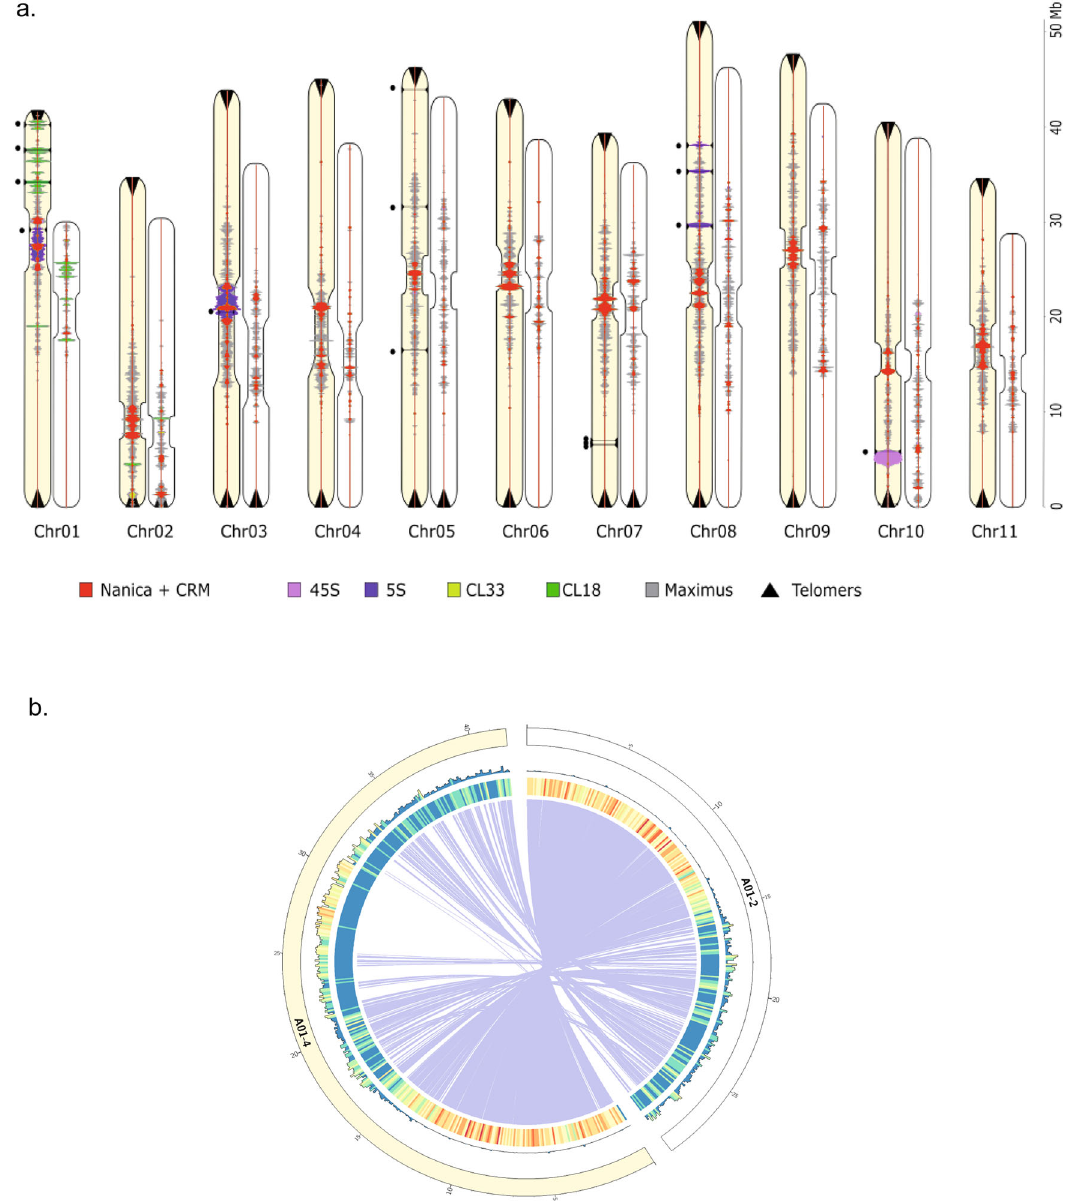
Fig. 2 Comparison of the V2 and V4 assemblies. a Localization and density of several repeated elements on chromosome sequences of the V4 (light orange) and V2 (white) assemblies (scale in Mbp on the right) with Nanica LINE and CRM chromovirus Gypsy retrotransposon (red), 5S rDNA (blue), 45S rDNA (violin), tandem repeat cluster CL18 (dark green), tandem repeat cluster CL33 (light green), Maximus Copia retrotransposon (gray) and telomeric sequences (black triangles). Horizontal black lines and black dots correspond to the 15 remaining gaps in the V4 assembly. b Comparison of the A01 chromosomes of the V2 and V4 assemblies. Tracks represent the following elements (from outer to inner): (1) density of the centromeric repeats. (2) Density of genes. (3) Synteny relationships between the V2 chromosome 1 and the V4 chromosome